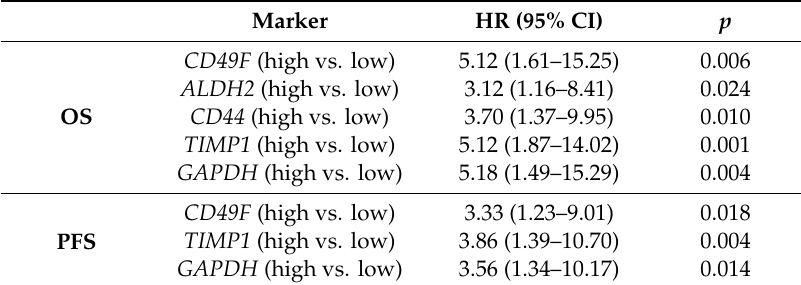
Table 4. Univariate Cox regression analysis for CTC